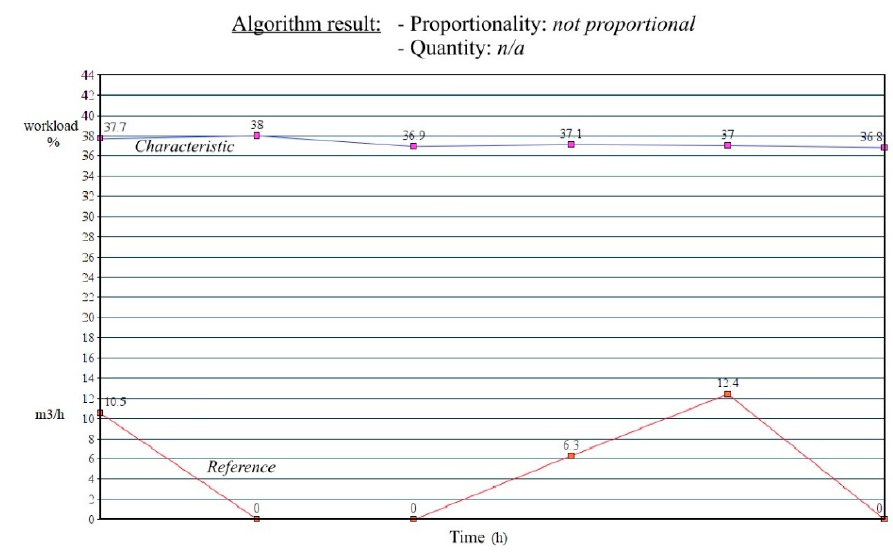
Figure 9. Test case graphical representation.